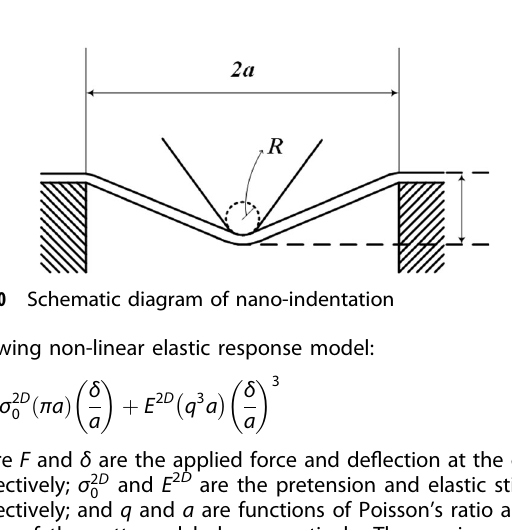
Fig. 9 Schematic diagrams of a typical force-indentation depth curve and b contact morphology between indenter and sample